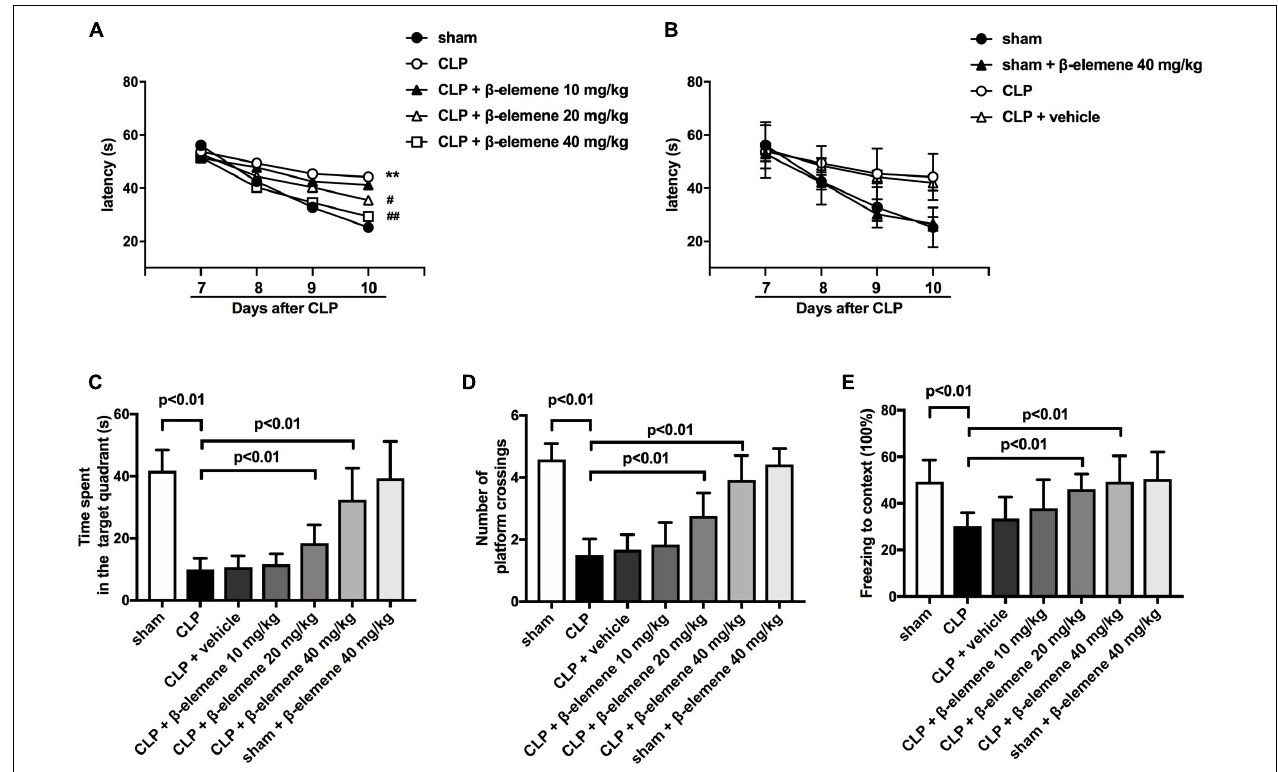
FIGURE 3 | β -Elemene improved learning and memory in septic mice induced by CLP. (A) β -Elemene significantly shortened CLP-induced prolongation of CLP-induced latency time. F(6, 308) = 11. (B) β -Elemene did not affect the latency time of the sham group and vehicle did not influence that of CLP mice. F(6,308) = 11. (C) β -Elemene extended the time spent in the target quadrant. F(6, 77) = 45.56. (D) β -Elemene significantly increased the number of platform crossings. F(6, 77) = 54.78. (E) β -Elemene prolonged the freezing time in the context test. F(6, 77) = 8.943. n = 12. Two-way or one-way ANOVA revealed a significant difference at ∗ p < 0.05 and ∗∗ p < 0.01 versus sham group; and # p < 0.05 and ## p < 0.01 versus CLP